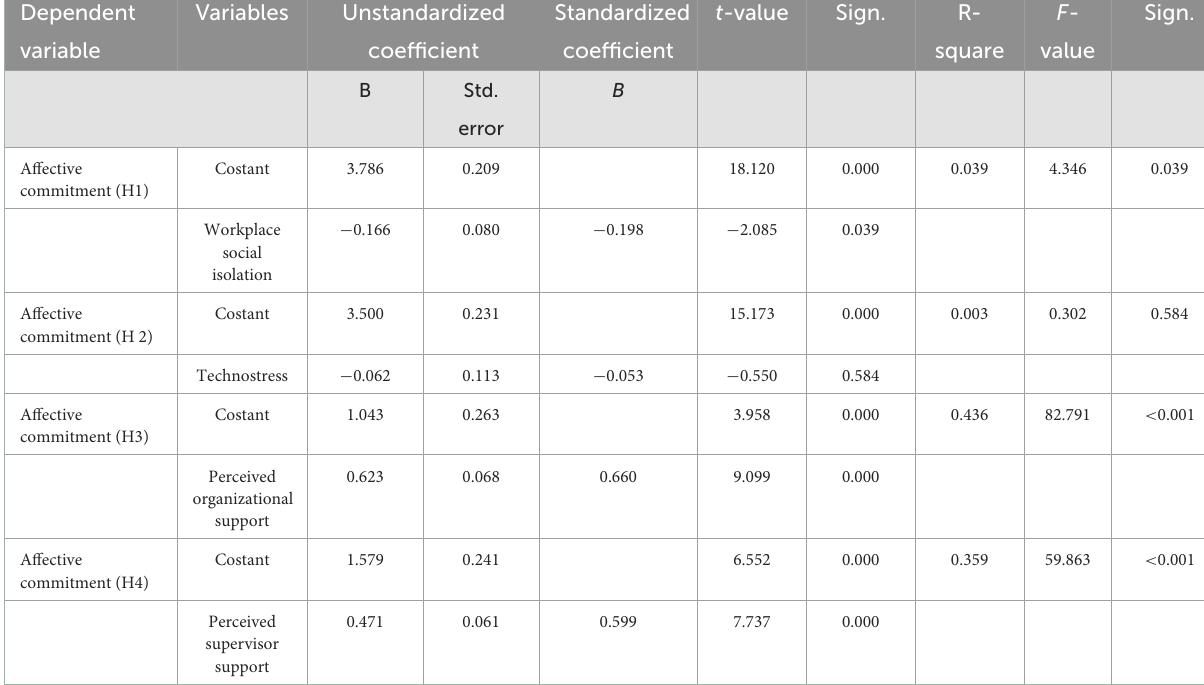
TABLE 3 Results of regression equations. Dependent Variables Unstandardized Standardized t -value Sign.